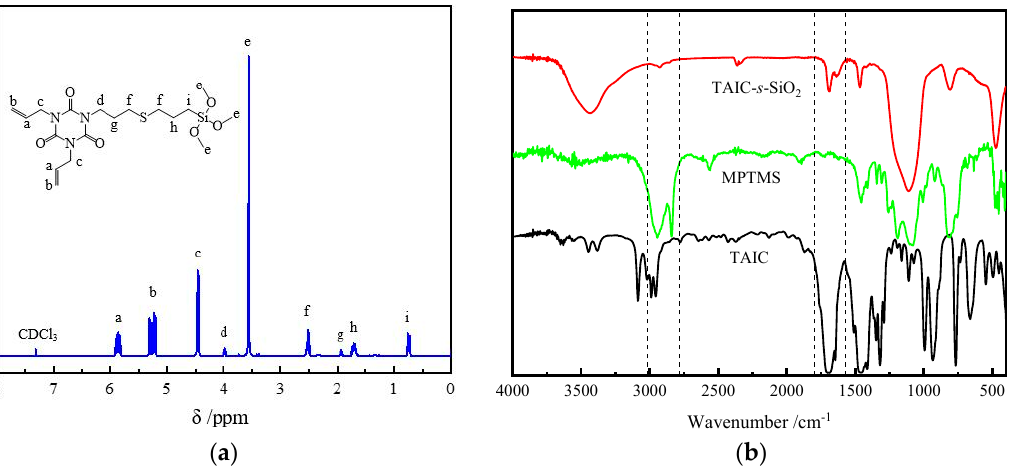
Figure 4. ( a ) 1 H-NMR spectrum of MTAIC molecules and ( b ) FTIR transmission spectra of TAIC- s -SiO 2 , MPTMS and TAIC.